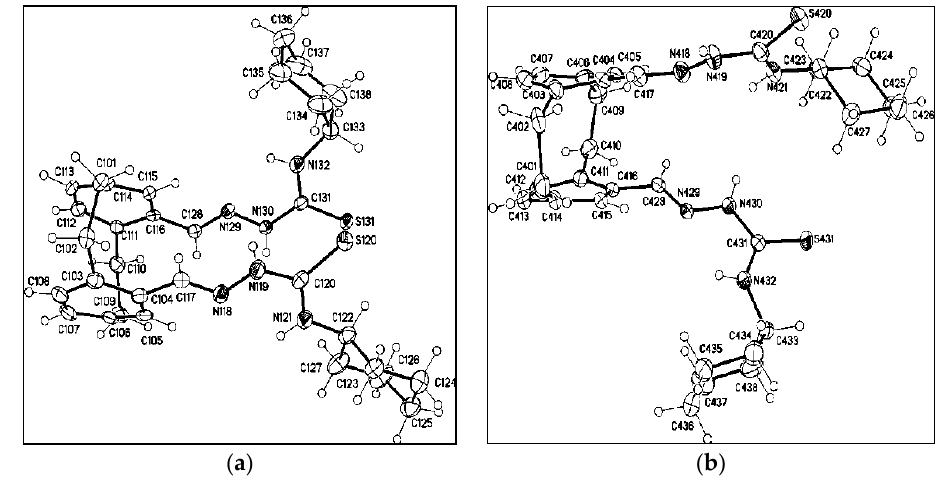
Figure 5. Molecular structure of two of the four crystallographic independent molecules of 25 showed the two different conformations in the crystal (displacement parameters, are drawn at 30% probability level).